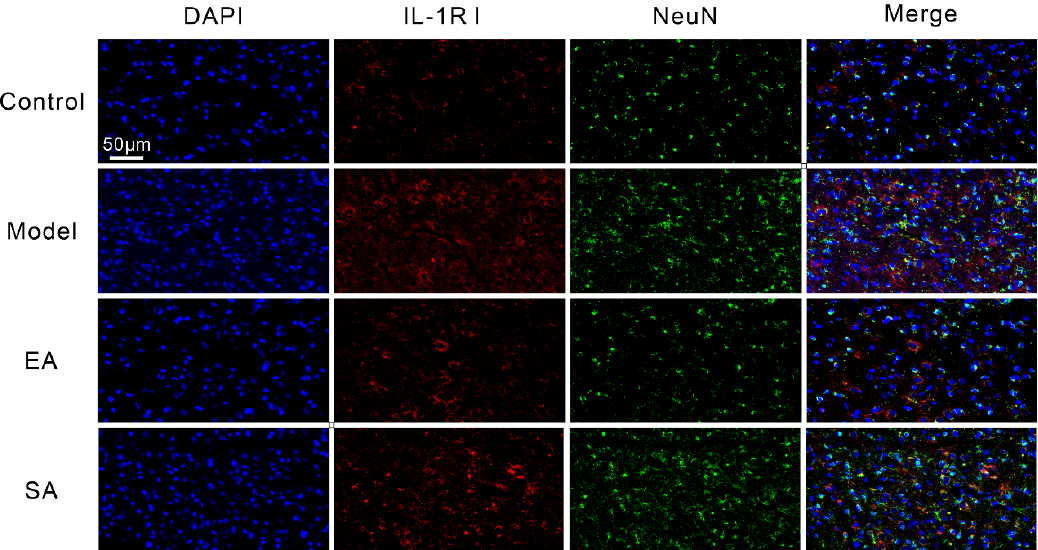
Figure 5. Representative immunofluorescent and protein expression of inflammatory factor receptor IL-1 β RI in TNC. Shown are NeuN (green) and inflammatory factor receptor IL-1 β RI (red) double-labeled cells in the TNC (400×, Scale bar = 50 µm, n = 4, three sections/rat).